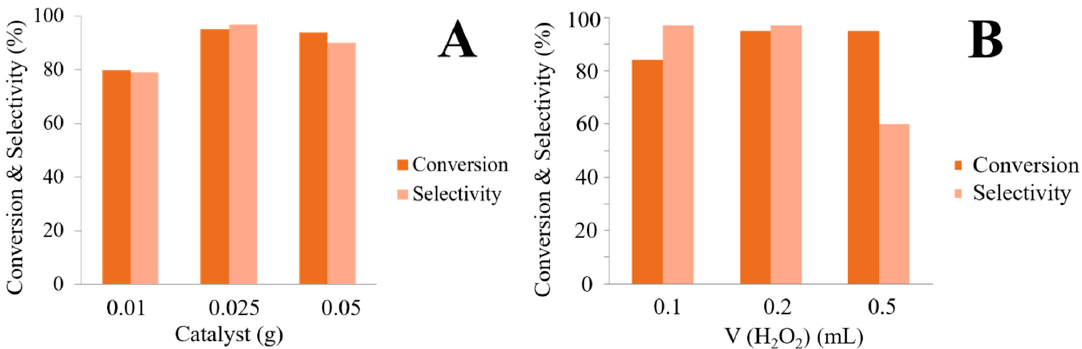
Figure4. E ff ectofthereactionparametersonthecatalyticperformanceof γ -Fe 2 O 3 / SiO 2 -STZ( A Figure 4. Effect of the reaction parameters on the catalytic performance of γ -Fe 2 O 3 /SiO 2 -STZ ( A )